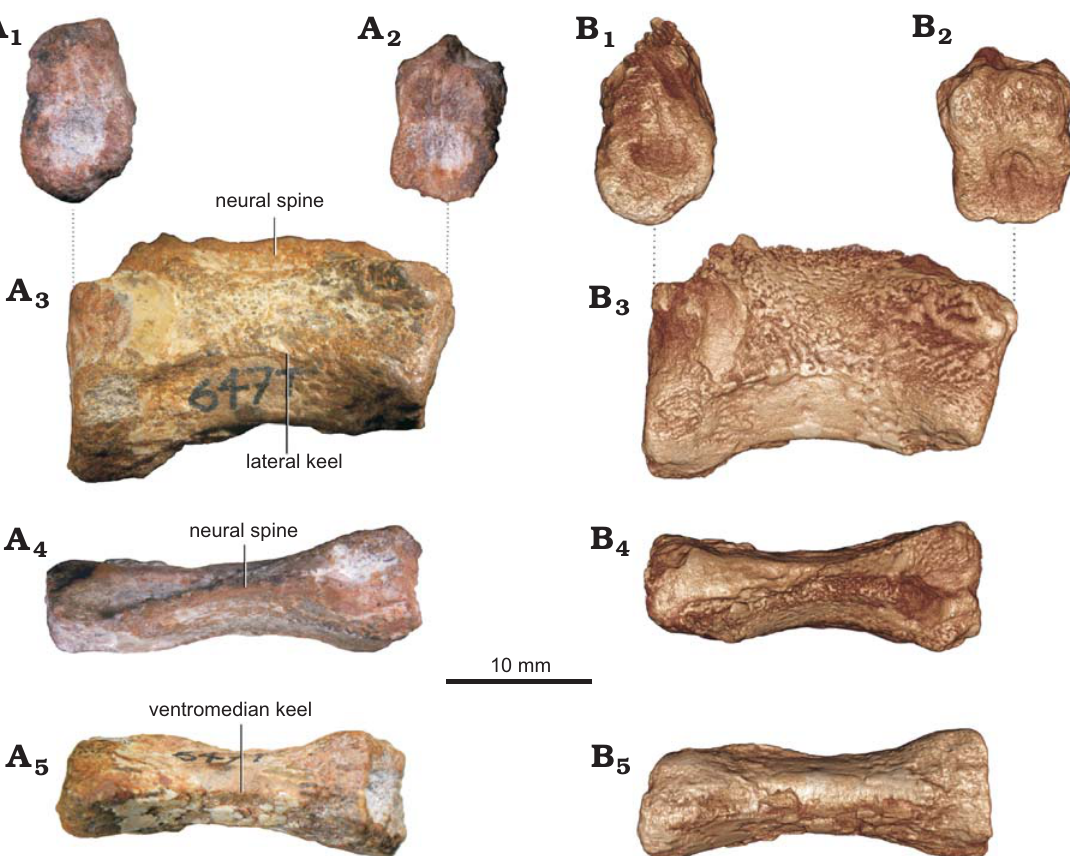
Fig. 3. Cervical vertebra (UFRGS-PV-647-T) of ?Tanystropheidae indet. from Sanga do Cabral Formation (Induan–early Olenekian). A . Photographs. B . Virtual 3D reconstructions (see SOM 2). In posterior (A 1 , B 1 ), anterior (A 2 , B 2 ), right lateral (A 3 , B 3 ), dorsal (A 4 , B 4 ), and ventral (A 5 , B 5 )